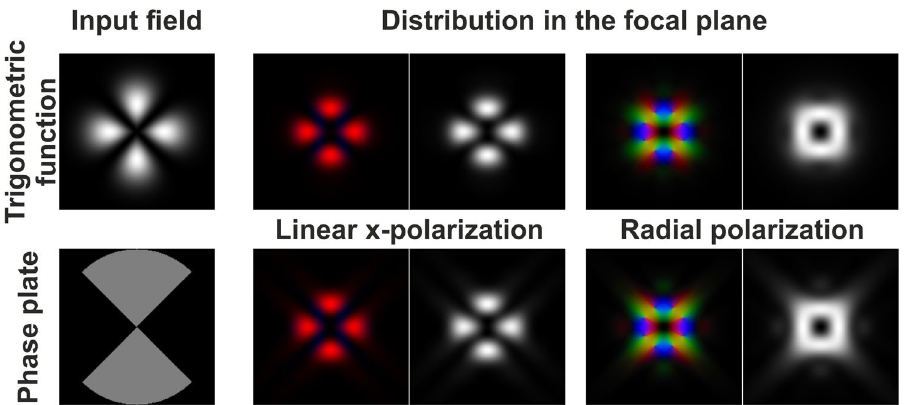
Figure 3. Comparison of the focusing of a Gaussian beam with linear polarisation and radial polarisation when the beam is multiplied by the cos(2 ϕ ) function (upper row) and when it passes through the binary plate in the